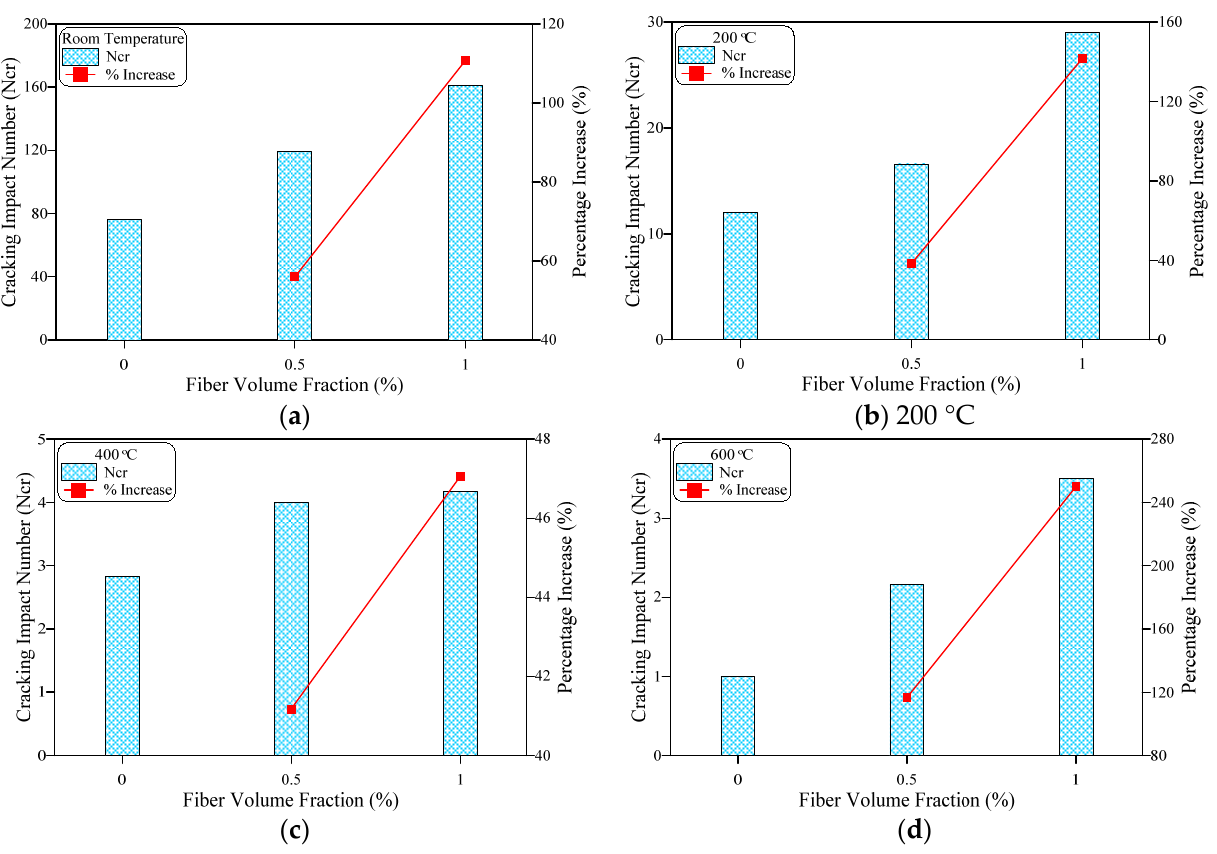
Figure 10. Cracking impact number results of disc specimens. ( a ) Room temperature; ( b ) 200 °C; ( c ) 400 °C; ( d ) 600 °C.